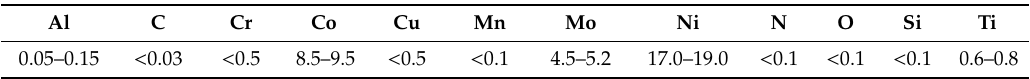
Table 2. Chemical composition range of maraging 300 Steel powder (wt.%). Source: EOS